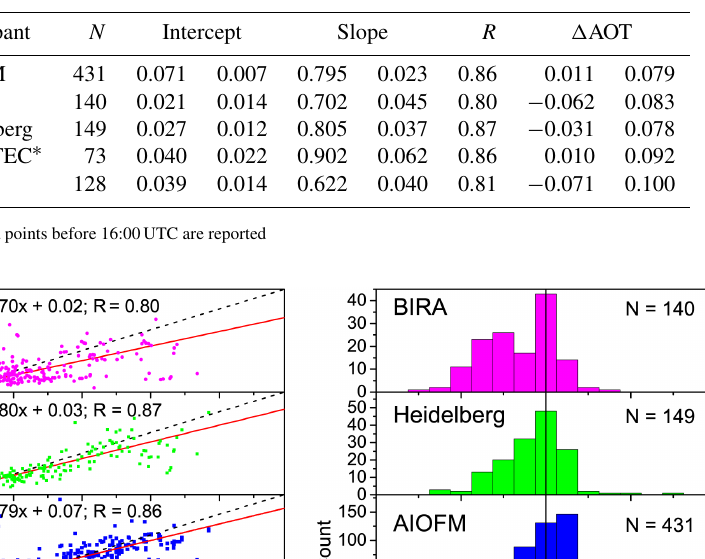
Table 2. Comparison between the AOT from MAX-DOAS and from sun photometer. Listed are the number of data points, intercept, and slope of the linear regression, the correlation coefficient R , the mean difference (MAX-DOAS minus sun photometer), and the standard deviation of the mean difference.